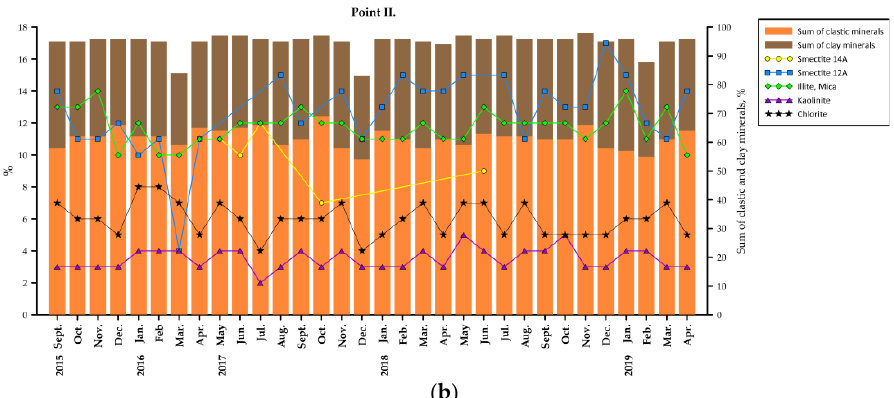
Figure 4. ( a ) Variations of the sum of clastic and clay minerals and main clay minerals for sampling point I. ( b ) The same as in ( a ) but for sampling point II.